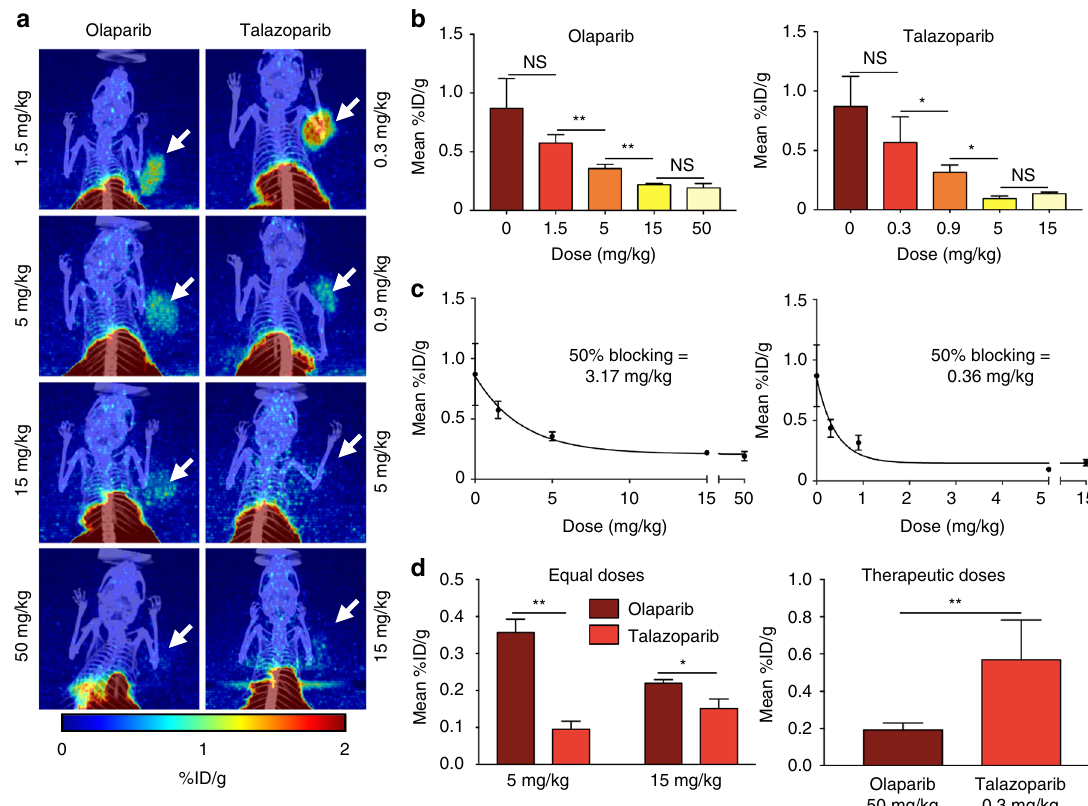
Fig. 7 Variable dose blocking. JHU-LX48 SCLC PDX bearing mice ( n = 3/group, 9 groups, 27 total) were injected (i.v.) fi rst with olaparib (0 – 50 mg/kg) or talazoparib (0 – 15 mg/kg). Mice were injected (i.v.) with 200 – 300 μ Ci of [ 18 F]PARPi 30 min later, and imaged via PET/CT 2 h later. a Representative MIPs from 4 different doses each, for olaparib (left) and talazoparib (right). b Quanti fi cation of PET images for tumor uptake at each of 4 different doses of olaparib (left) and talazoparib (right), compared to [ 18 F]PARPi only. c Curve fi tting analysis for olaparib (left) and talazoparib (right) showing calculated 50% blocking doses. d Comparison of olaparib and talazoparib at equal doses (left) and at therapeutic doses (right). Non-parametric Student ’ s t -test was used to calculate the statistics. * P < 0.05; ** P < 0.01. Error bars represent the 45% (Fig. 6e). A signi fi cant reduction of [ 18 F]PARPi was also observed in muscle tissue, despite the low PARP1 expression.